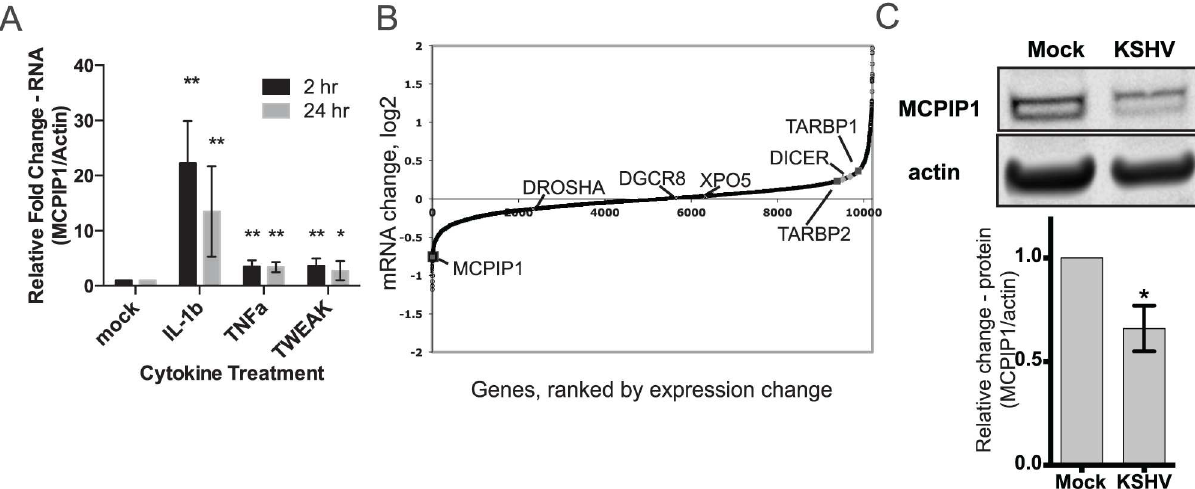
Fig 3. KSHV infection affectsexpression of miRNA biogenesis machinery. (A) HUVECs were treated with cytokines: IL-1 β , TNF α , and TWEAK. Total RNA was harvestedat 2 or 24 h after treatment, and MCPIP1 expressionwas measured using qPCR. Results are shown relativeto β -actin and normalized to the untreated control. N = 5–11 per group. (B) Host mRNA expressiondata in KSHV latently infected HUVECs (48 hpi) [20]. Expression changesof Dicer, MCPIP1, TARBP1, and TARBP2 are indicated. (C) Western blots for MCPIP1 protein are shown for HUVECs that were either mock-infected or infected with KSHV, N = 3. For all graphs, results are shown as mean ± SD. Significance was assessedusing a Student’s t test, * p (cid:20) 0.05, ** p (cid:20) 0.01. Numericaldata can be found in S1